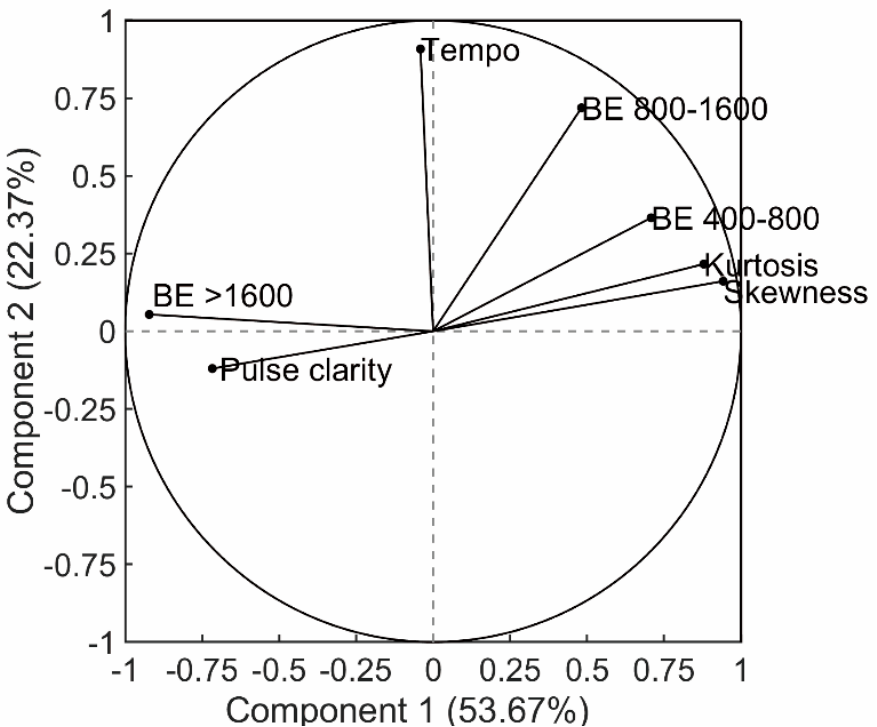
Figure 7. The correlation between the original features and the two principal components.